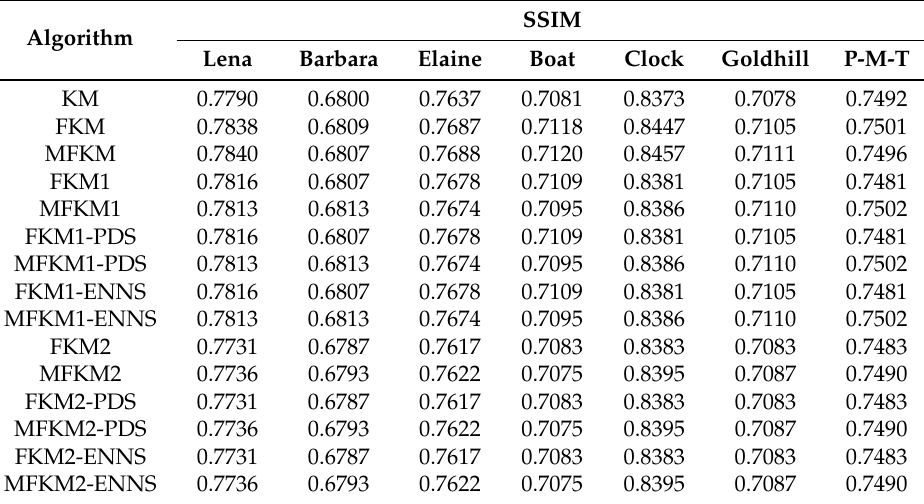
Table 10. SSIM for images Lena, Barbara Elaine, Boat, Clock, Goldhill and P-M-T, using N = 32.